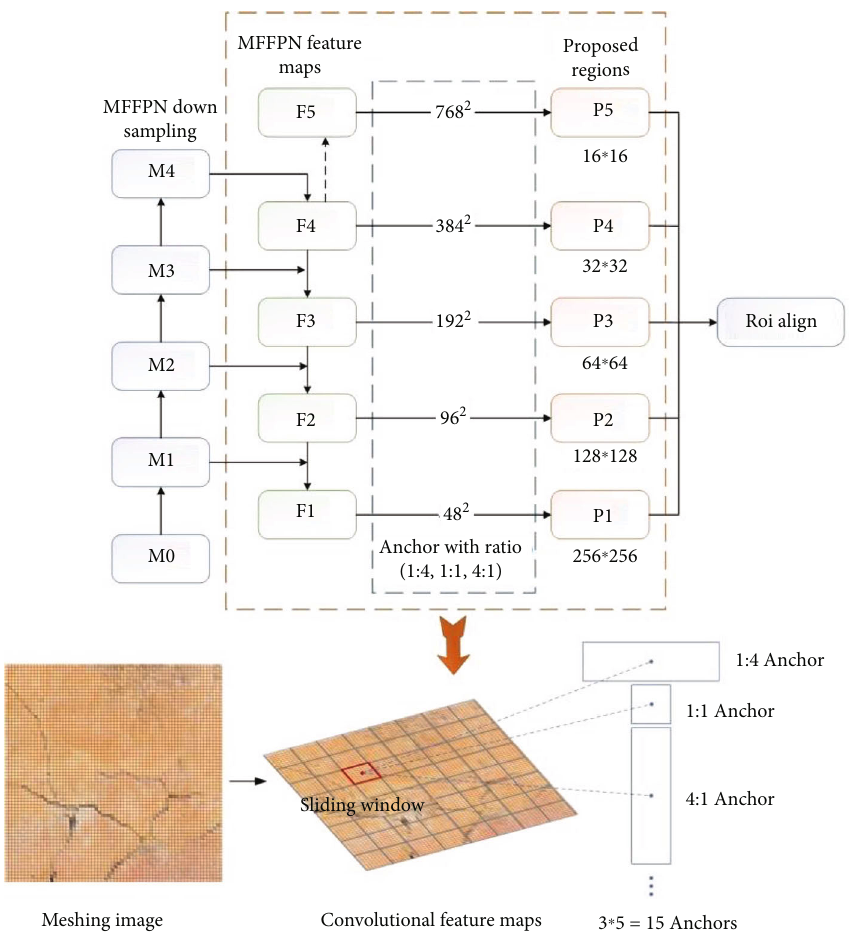
Figure 8: Framework of regional proposal network.